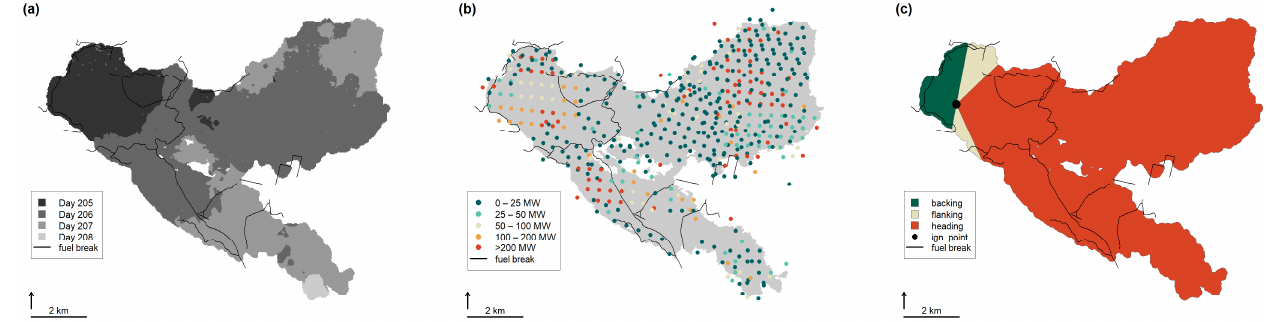
Figure 3. Example fire behavior variables for the 2018 Cranston Fire showing: ( a ) estimated date of burning in day of the year, ( b ) FRP from MODIS and VIIRS, and ( c ) spread encounter type.